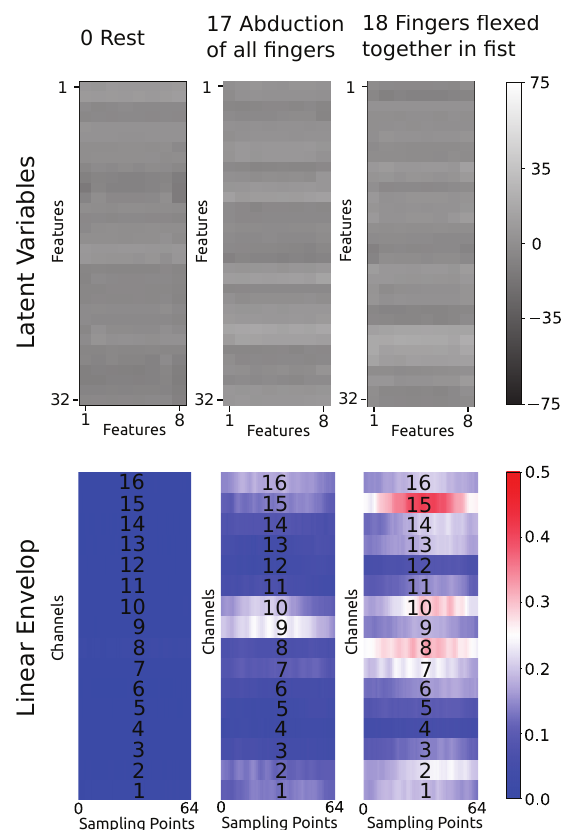
Figure 8. The feature centers of different hand gestures, and their reverse transformation to the sEMG linear envelope.